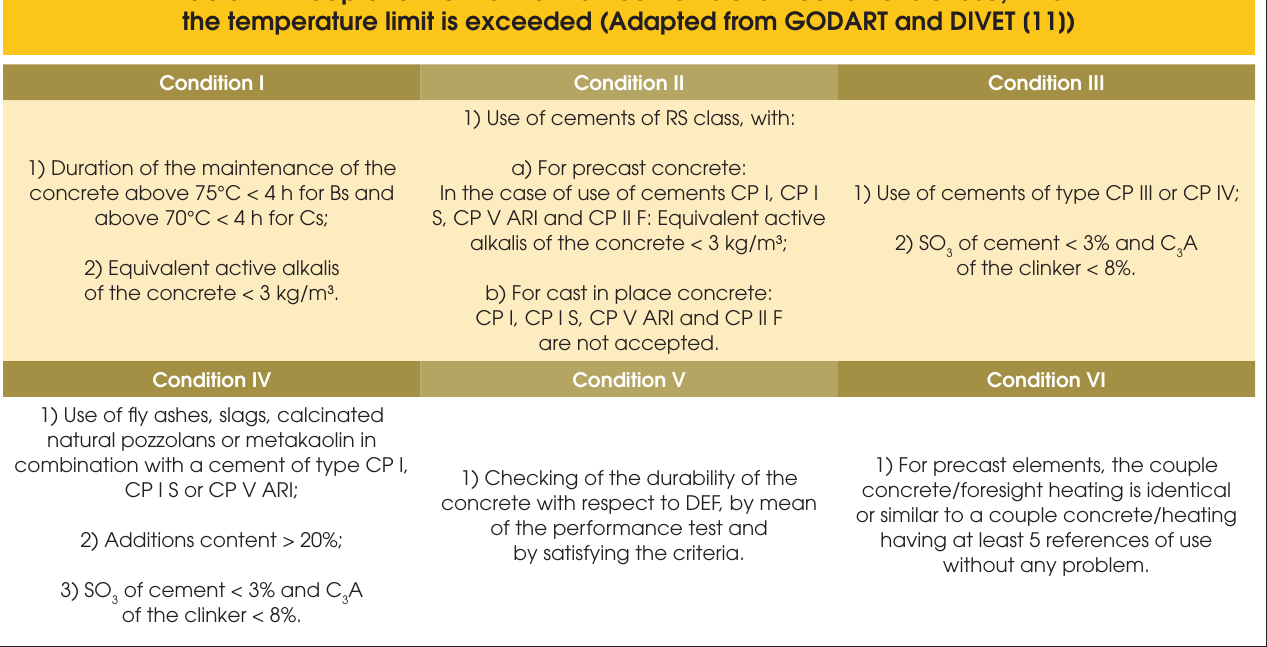
Table 4 – Adaptation to the Brazilian cements of six conditions of use, when the temperature limit is exceeded (Adapted from GODART and DIVET